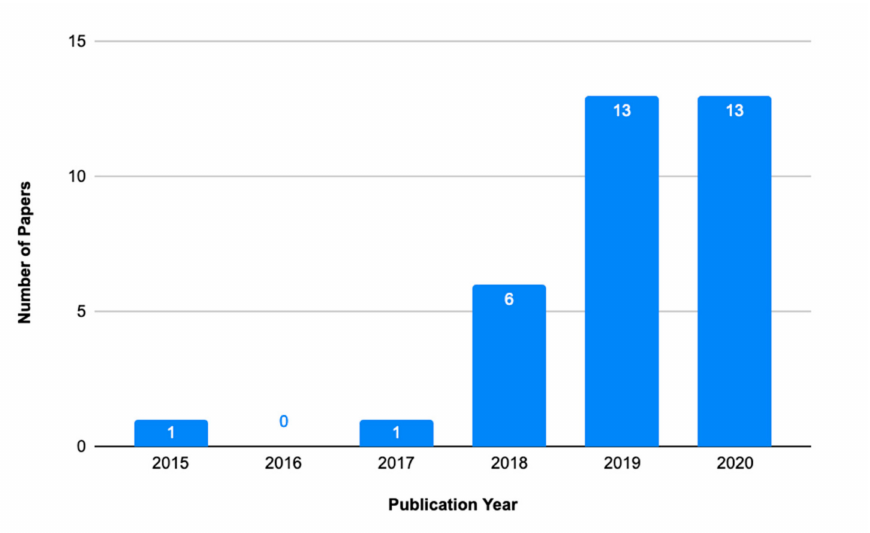
Figure 5. Distribution of papers selected by year.